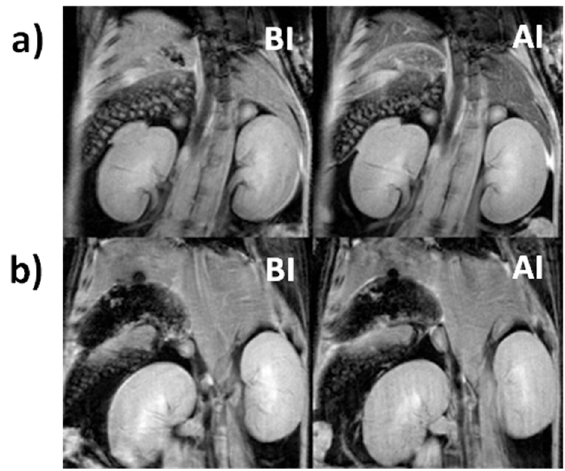
Figure 4. Coronal magnetic resonance (MR) images of the abdominal cavity of mice before (BI) and after (AI) injection of aged ( a ) or freshly ( b ) prepared solutions of IONPs.